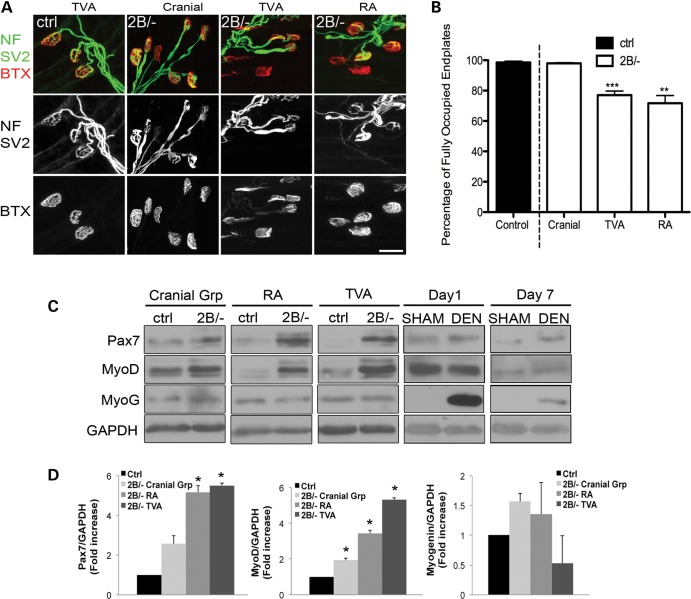
The myogenic program is altered even in muscles not subject to denervation in Smn2B/− mice. (A) Representative images showing fully intact NMJs from cranial, TVA and RA muscles of control and P21 Smn2B/− mice. Postsynaptic acetylcholine receptors were labeled with alpha-bungarotoxin (BTX, red) while the presynaptic terminal was labeled with antineurofilament (NF, green) and antisynaptic vesicle protein 2 (SV2, green). (B) Quantification of fully occupied endplates revealed differences between control and the TVA and RA muscles from Smn2B/− mice but not for cranial muscles, suggesting that the latter are not subject to denervation. (C) Representative immunoblots showing altered protein levels of Pax7 and MyoD in innervated (cranial) and denervated (RA and TVA) muscles of Smn2B/− mice. Interestingly, Pax7 and MyoD levels are unaffected in muscles following experimental denervation, at 1 or 7 days postsurgery. By comparison, a robust increase in myogenin levels can be detected as early as 1 day postdenervation and persists to 7 days following denervation. (D) Quantification analyses revealed differences in Pax7 and MyoD protein levels in all three muscle groups examined. The levels of myogenin however, were similar between control and Smn2B/− mice for innervated and denervated muscles. (MyoG = myogenin, DEN = denervated). Scale bar = 20 μm. N = 3 for all experiments. *, P < 0.05; **, P < 0.01, ***, P < 0.001.